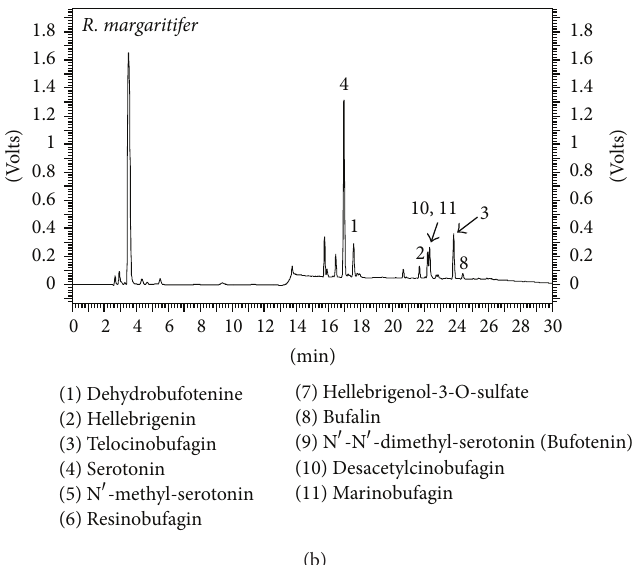
Figure 1: C18-RP-HPLC profiles ( 𝜆 = 214 nm) of the parotoid secretion of the studied toads in this work with the identified molecules annotated.